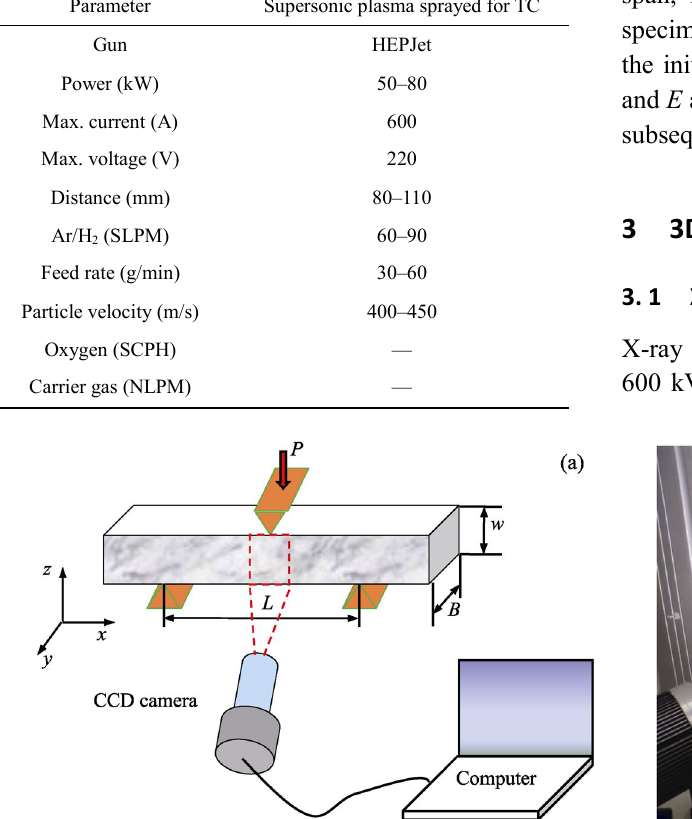
Table 1 Preparation parameters of GYbZ coating by SPS Parameter